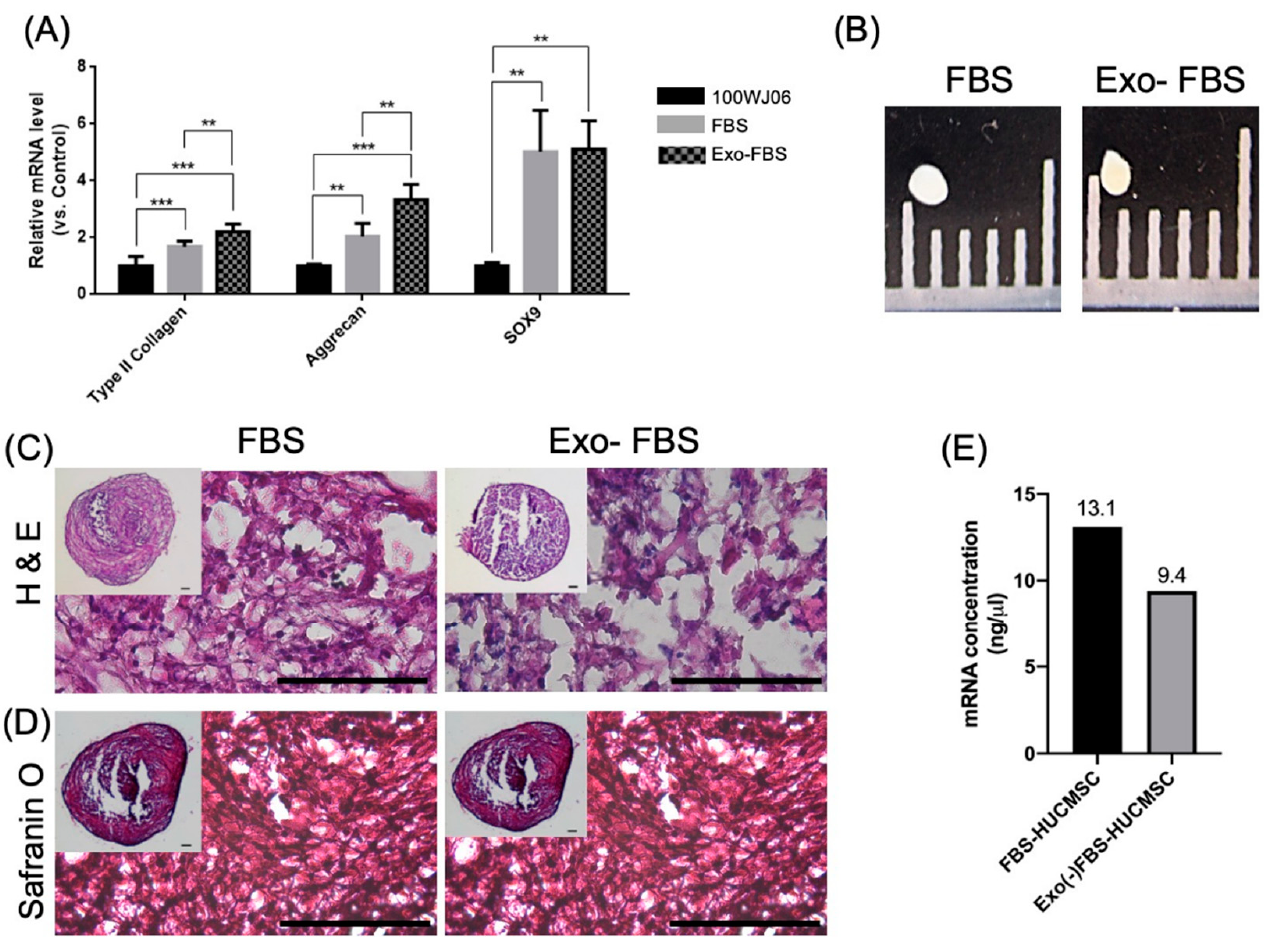
Figure 3. Chondrocyte gene expressions and immunohistochemistry (IHC) of exosome +/ − FBS- cultured HUCMSCs. ( A ) qRT-PCR shows chondrogenic gene expressions (SOX9, aggrecan, and type II collagen) in exosome +/ − FBS-cultured HUCMSCs cultured after chondrogenesis. ** p < 0.01, *** p < 0.001. Representative results from 3 experiments. ( B ) Gross picture of exosome +/ − FBS- cultured HUCMSCs-differentiated cartilage pellet. Scale = 1 mm. ( C ) Hematoxylin and eosin staining of the pellet. ( D ) Safranin O staining of the pellet differentiation from HUCMSCs. Inlet images showed the original size. Scalebar = 100 µ m. ( E ) mRNA concentration (ng/ µ L) after chondrogenic differentiation ( n = 1). ** p < 0.01, and *** p < 0.001. HUCMSCs were derived from the same donor (101WJ06).